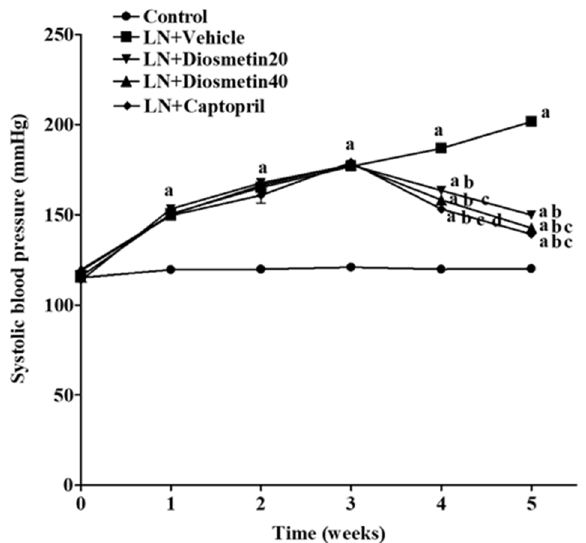
Figure 1. Changes in systolic blood pressure in conscious rats throughout the experimental period. a